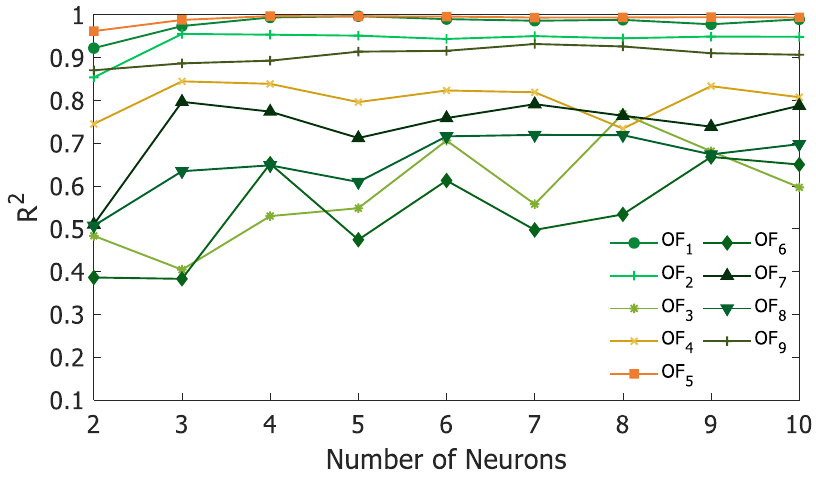
Figure 5 . R 2 values for all the objective functions using 50 learning and 20 validation uniform design (UD) design points vs. Number of neurons in the hidden layer.